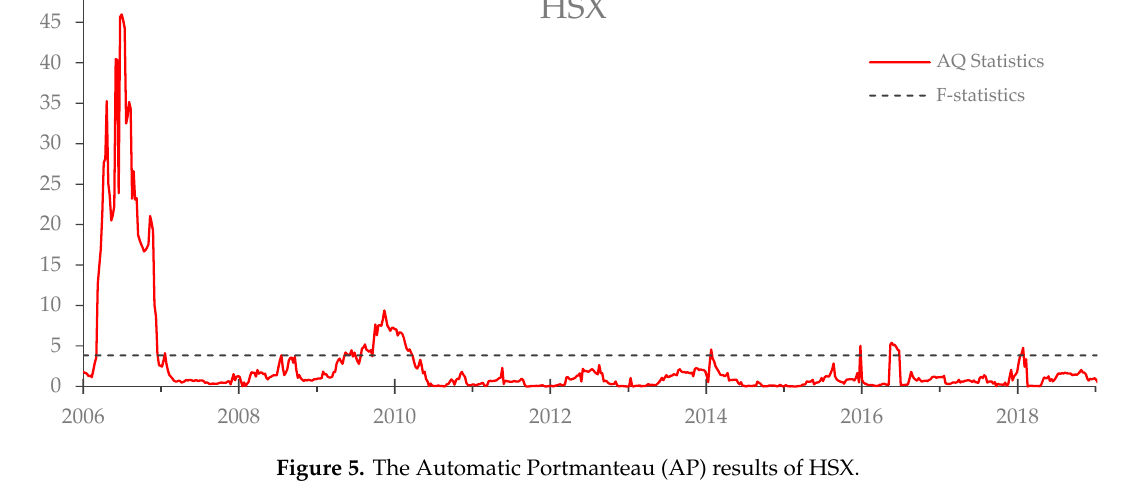
Figure 5. The Automatic Portmanteau (AP) results of HSX.